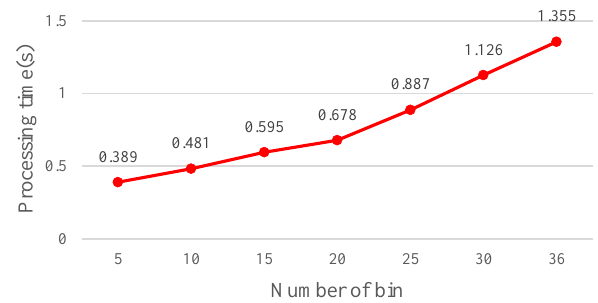
Figure 18. Computation time required for various numbers of rotations.